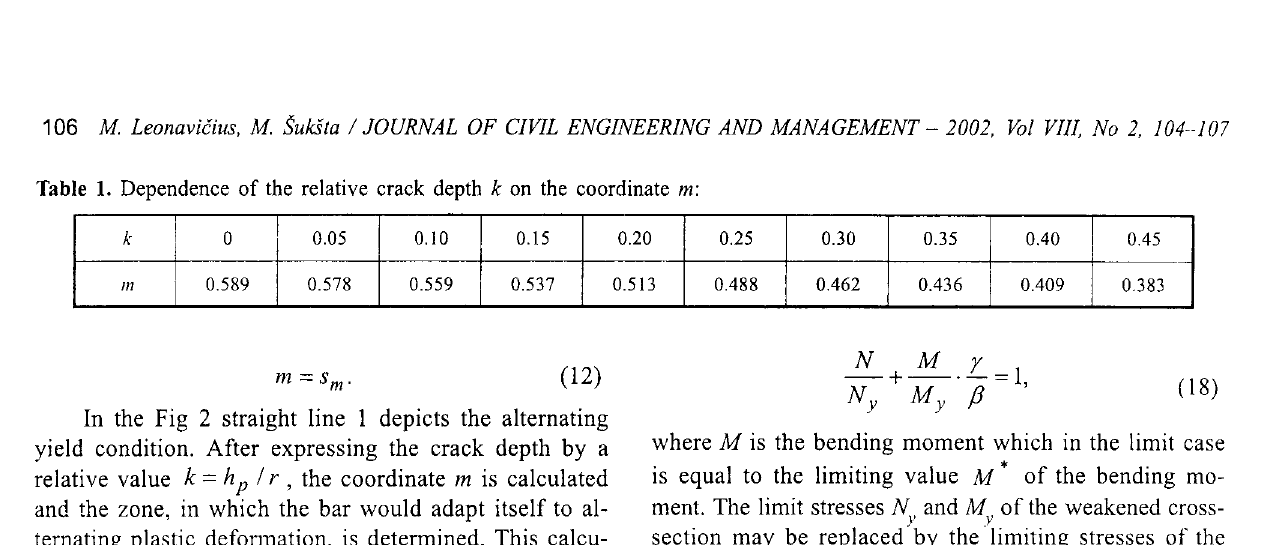
Table 1. Dependence of the relative crack depth k on the coordinate m: